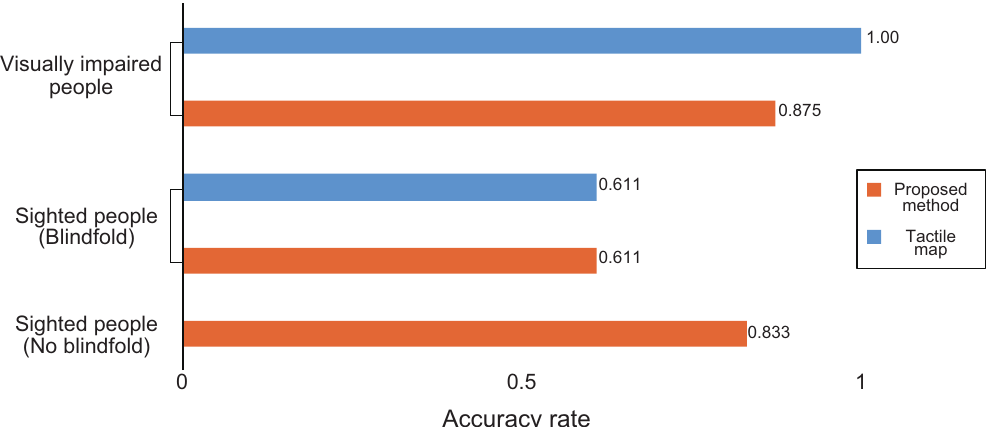
Figure 10. Accuracy rate: In the proposed method, the accuracy was almost the same between those without a blindfold and those with visual impairment. For the tactile map, the accuracy of the visually impaired subjects was 100%, which was different from that of the sighted